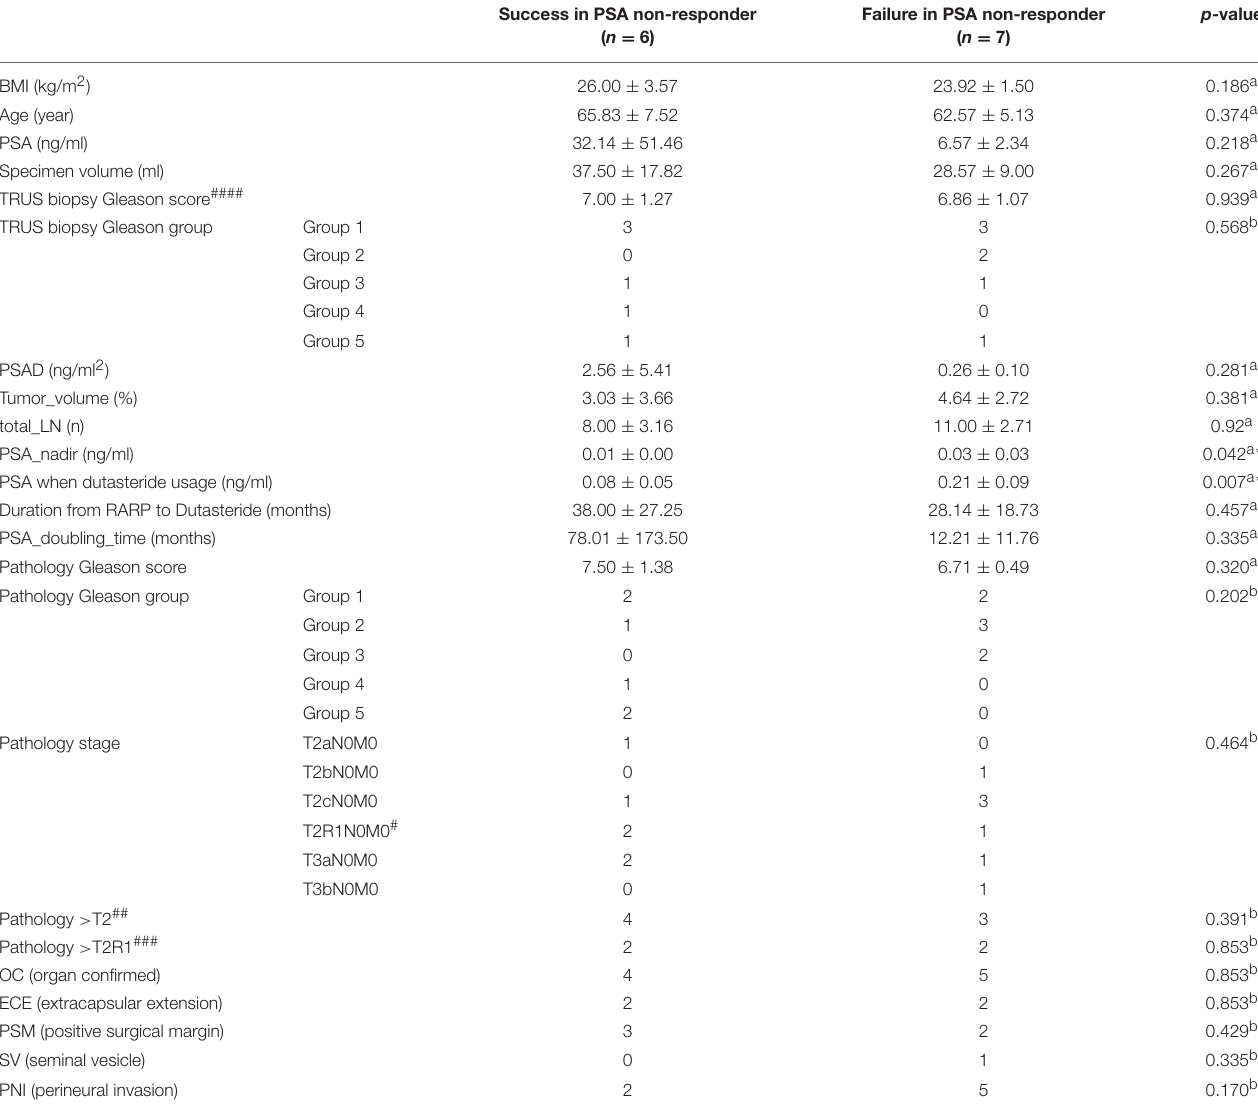
TABLE 3 | Comparison of clinicopathological variables of success with failure in